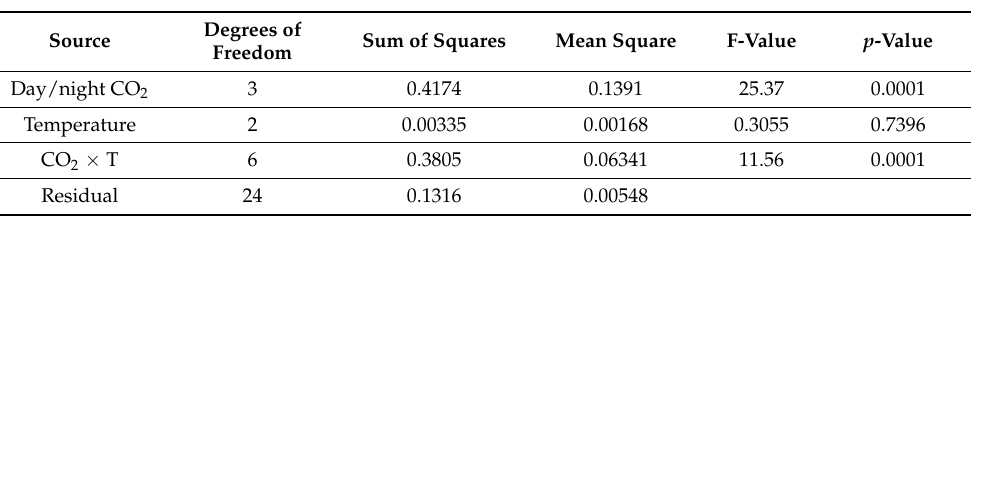
Table A4. Analysis of variance for leaf water potential of bean leaves under four day/night CO 2 conditions, at three growth